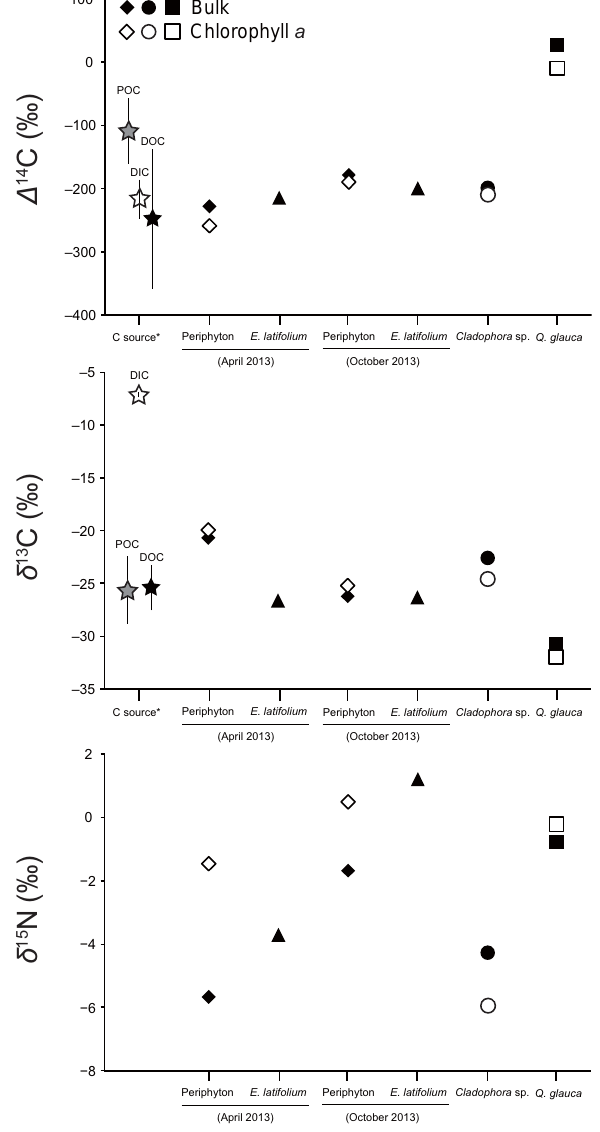
Figure 1. The (cid:49) 14 C bulk , δ 13 C bulk and δ 15 N bulk values (closed symbols) and the (cid:49) 14 C chl , δ 13 C chl and δ 15 N chl values (open sym- bols) for periphyton (diamonds), Cladophora sp. (aquatic primary producer, circle), Q. glauca (terrestrial primary producer, square) and E. latifolium (algal grazer, triangles). DIC: dissolved inorganic carbon; DOC: dissolved organic carbon; POC: particulate organic carbon. ∗ Data from Ishikawa et al. (2012b,